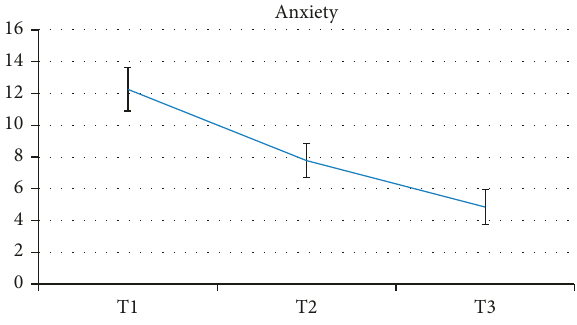
Figure 3: Time changes in anxiety scores.